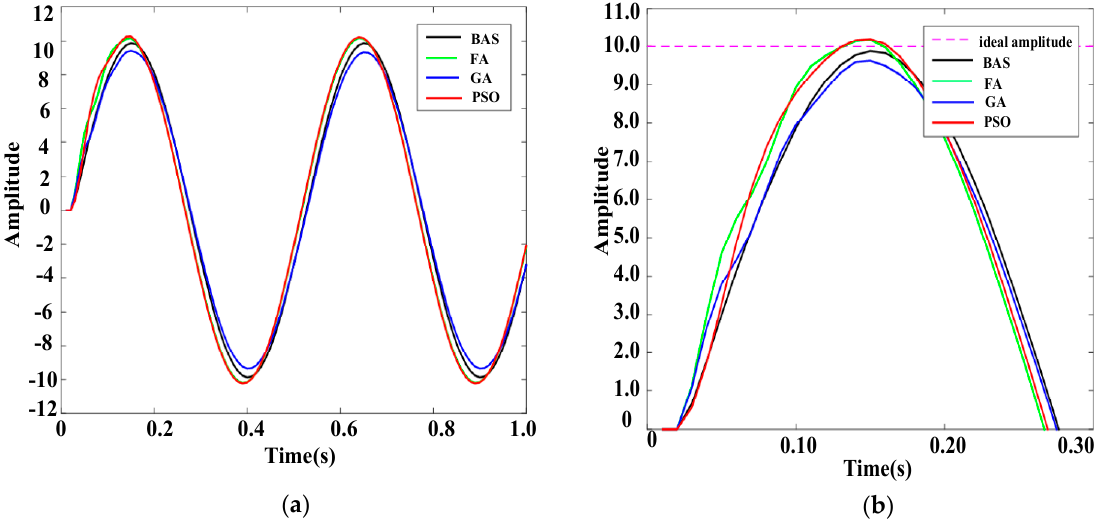
Figure 14. Response curves of the sinusoidal signal whose amplitude is 10. ( a ) Whole response curves. ( b ) Local amplification curves.